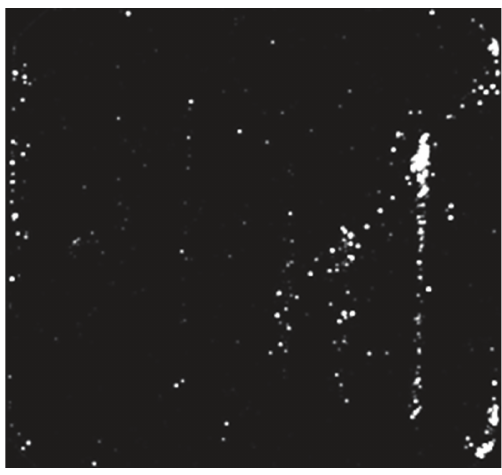
Figure 9: Microplasma method-scanning time 20 s, reverse voltage 8.0V, sample no.